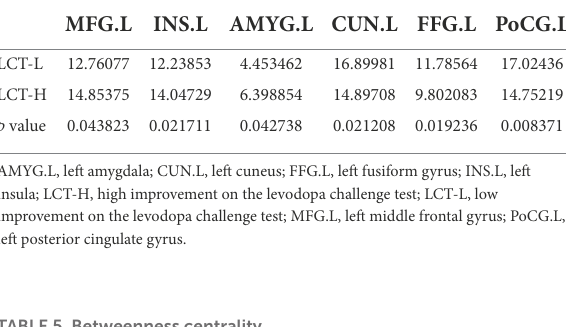
TABLE 4 Six significant nodes with average degree.